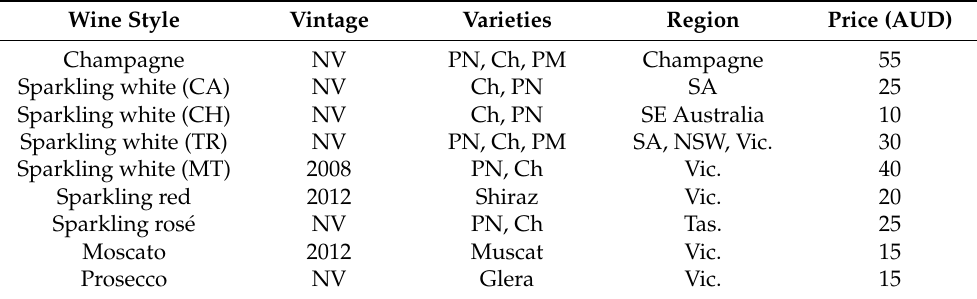
Table 1. Vintage, varietal composition, geographical origin and price of the French Champagne and Australian sparkling wines